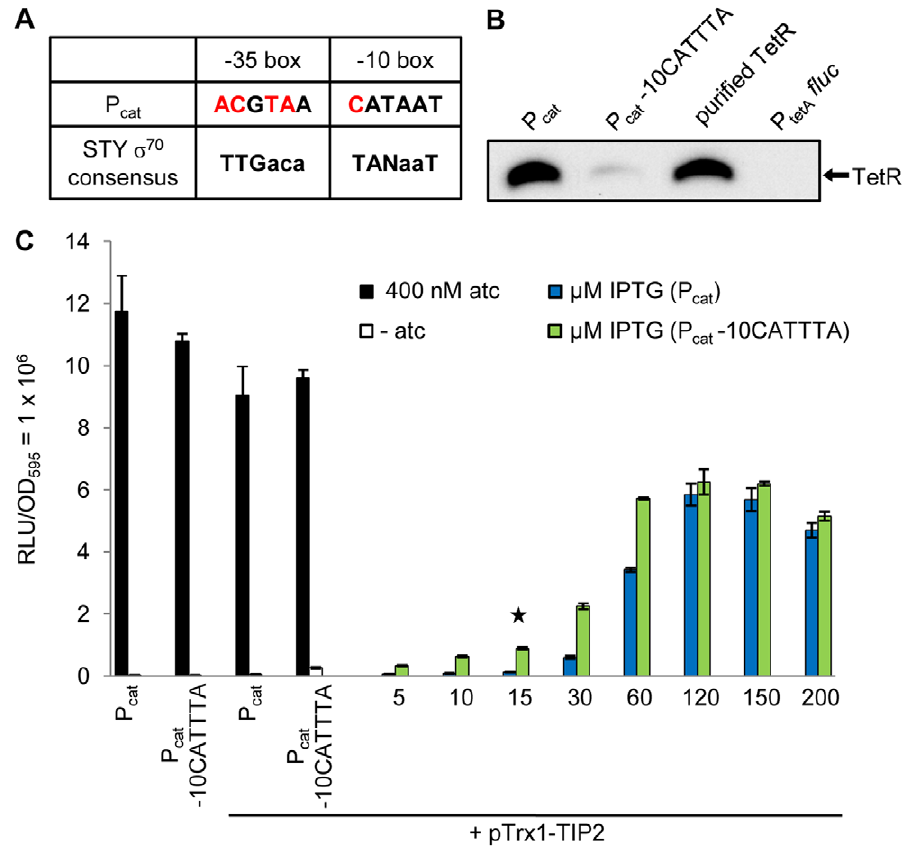
Figure 2. Analysis of the reporter system’s regulatory properties after directed mutagenesis of the P cat -10 element. (A) Comparison of the P cat and the S. Typhimurium (STY) s 70 consensus promoter sequences. Differences are highlighted in red. (B) Western blot for determining the steady-state level of TetR expressed by P cat or P cat -10CATTTA (5 m g crude protein extract of each) with a polyclonal anti-TetR antibody. As controls, 5 m g crude protein extract of the strain P tetA fluc (lacking TetR) and 30 ng of purified TetR were loaded onto the gel. (C) Dose-response curve to analyze the sensitivity of TetR induction by the plasmid-encoded Trx1-TIP2 fusion protein (pTrx1-TIP2) in strains expressing TetR either by P cat or by P cat -10CATTTA. These were incubated without and with 400 nM atc as control for maximum induction of TetR. Increasing IPTG concentrations were added for Trx1-TIP2 expression. The star marks the IPTG concentration at which the level of Trx1-TIP2 corresponds roughly to the endogenous Trx1 level. The bars illustrate the relative light units (RLU) which were normalized to a 1 ml culture with OD 595 =1. The data are a representative set from at least three independent measurements and display the mean 6 standard deviation.